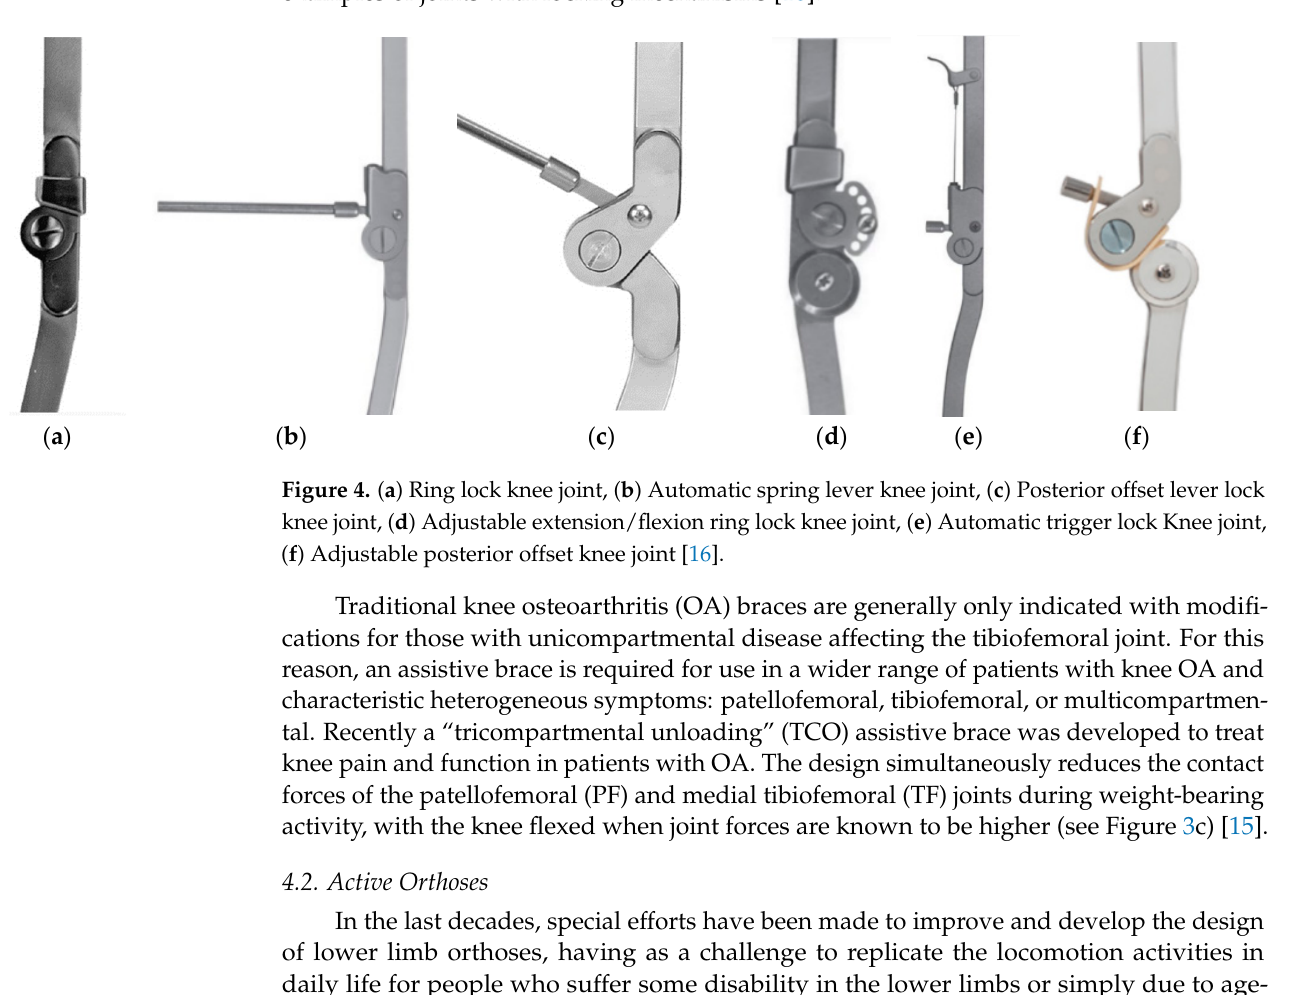
Figure 3. Knee orthoses: ( a ) A free knee joint with posterior axis [13], ( b ) Bilateral orthosis [14], ( c ) Tricompartmental Offloading Knee Brace (TCO) with spring hinge [15].